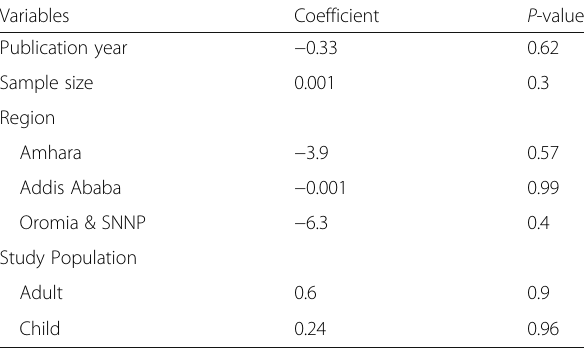
Table 2 Related factors with heterogeneity of treatment failure among ART users based on univariate meta-regression